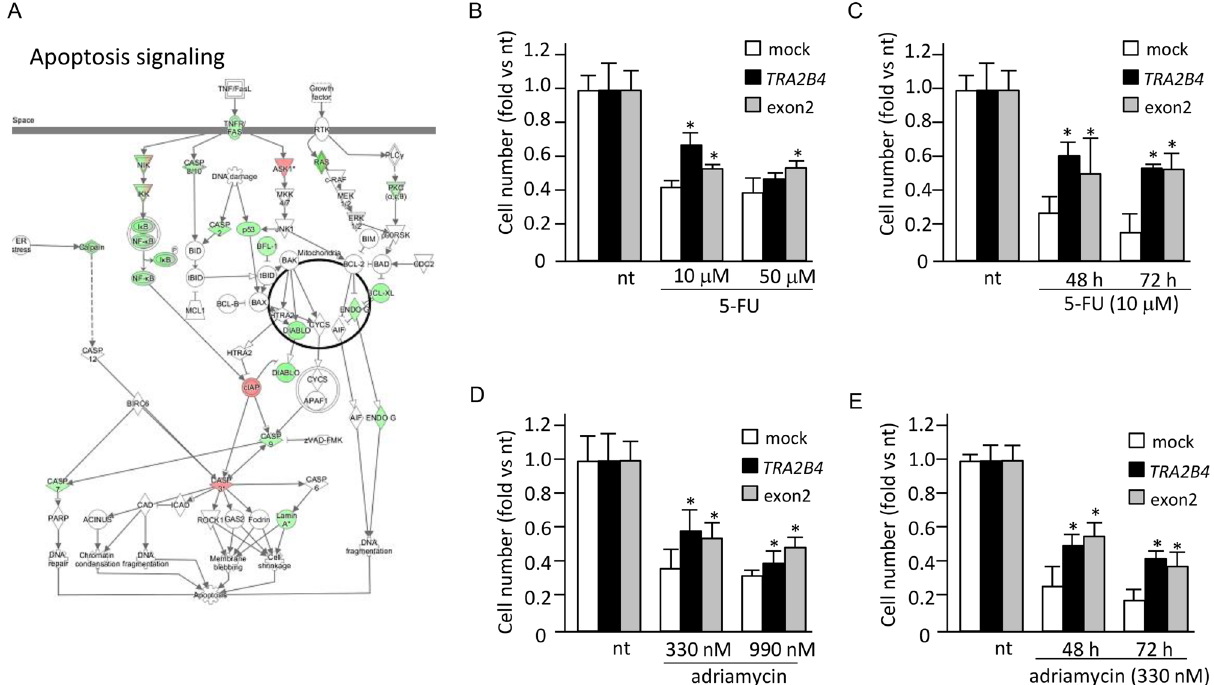
Figure 4. Effect of uc.138 on susceptibility to an anticancer drug. ( A ) Canonical pathways for “apoptosis signaling” represented by the differentially expressed genes between uc.138 overexpression and mock- transfected cells were analyzed using Ingenuity Pathway Analysis (QIAGEN Bioinformatics). The genes up- and down-regulated in uc.138 overexpressed cells are shown in red and green, respectively. ( B , D ) Human colorectal carcinoma (HCT116) cells with stable overexpression of TRA2B4 or exon 2 were exposed to 5-fluorouracil (5-FU) or adriamycin for 24 h at indicated concentrations. Subsequently, growing cells were harvested and counted. ( C , E ) The number of cells with stable overexpression of TRA2B4 or exon 2 was measured after exposure to 10 μM 5-FU or 330 nM adriamycin at different time-points (0, 48 and 72 h). nt: non-treatment. Values are mean ± SD from four independent experiments. *Significantly different by the unpaired Student’s t test compared with mock-treated cells ( p <